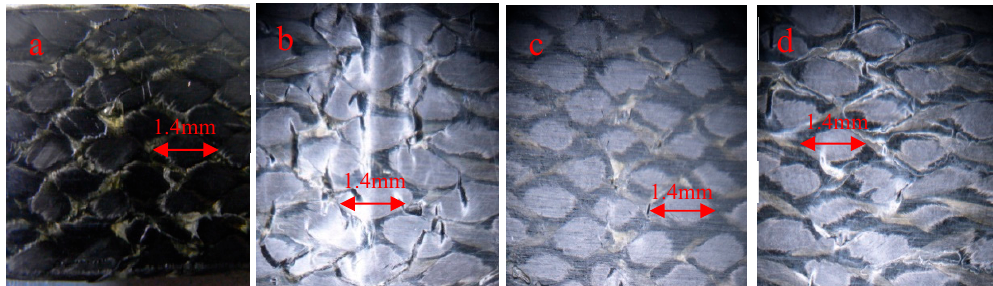
Figure 9. The compression surface morphology of 3Dim–5Dir braided composites with bending fracture at 110 °C and different durations ( a ) at room temperature; ( b ) 110 °C 0.25 h; ( c ) 110 °C 10 h; ( d ) 110 °C 30 h.